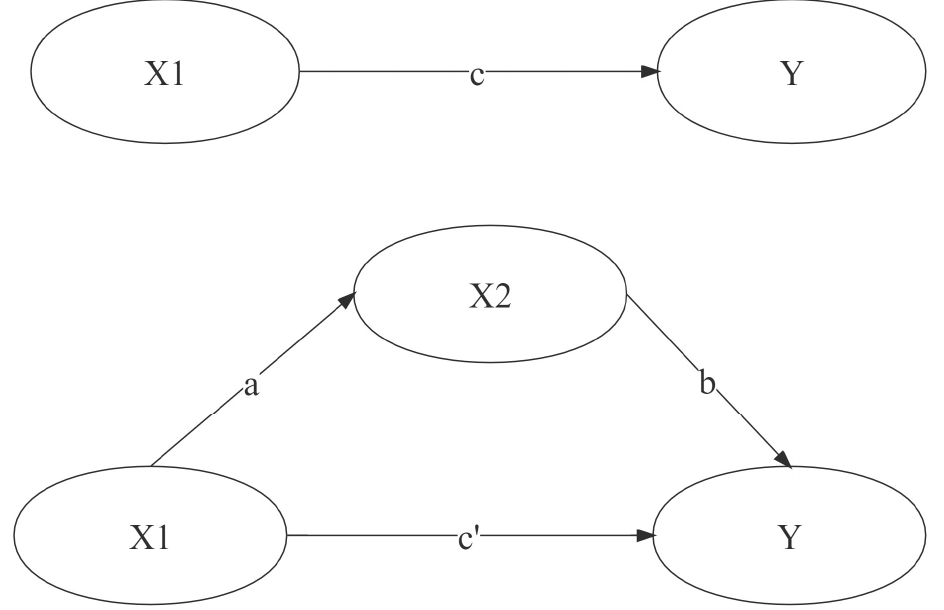
Figure 4. Mediation and suppression effects.